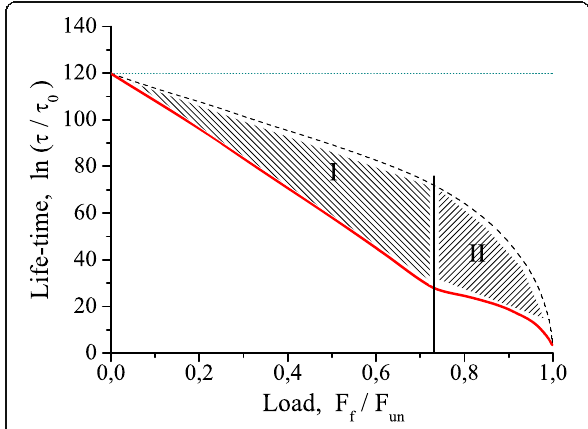
Fig. 7 Lifetime dependence on load at T=600 K: τ 0 =0.042 ps is the average period of atom vibration; F f is the value of applied load; F un is the ultimate tensile strength of a contact bond; I is the region where thermal fluctuations only initiate the contact bond break; II is the region where thermal fluctuations are both necessary and sufficient condition for failure; Solid line is the service time with account for the effect of internal forces at release of elastic strain energy. Dash line is the service time without account for above effect. Dot line is the service time by Arrhenius model (calculation by (15))